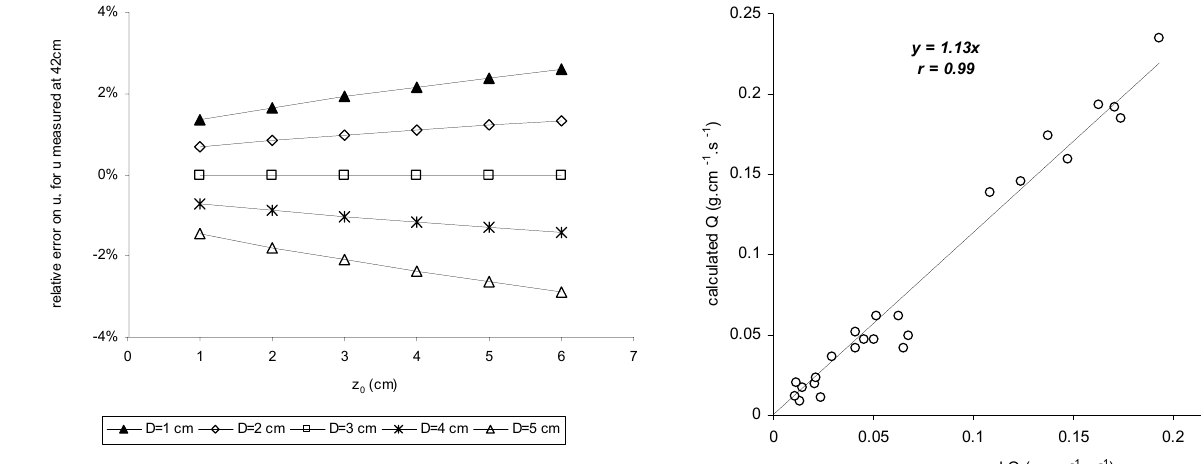
Fig. 6. Sensitivity of u ∗ (expressed in %) to the displacement height value D for different z 0 (relative error computed using D =3cm as a reference value). FIGURE 7 Fig. 7. Comparison between calculated and measured erosion fluxes for the additional data set (n=24). y = 1.13x r = 0.99